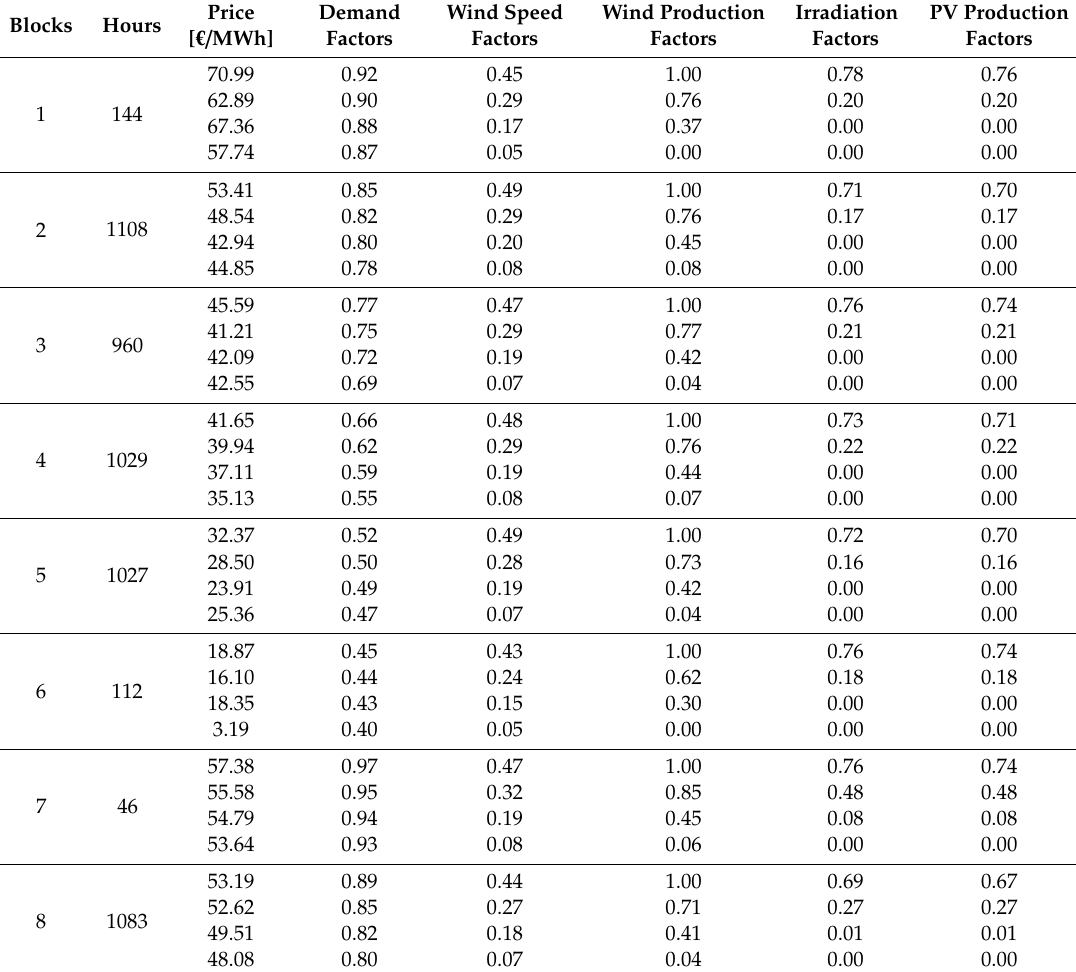
Table 3. Investment